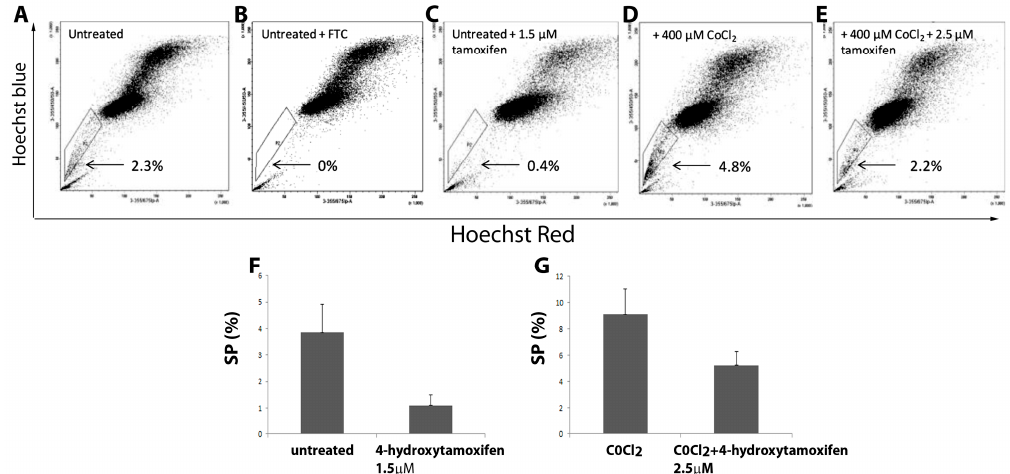
Figure 7. Analysis of the impact of CoCl 2 and drug treatment on MCF7 SP cells. Representative FACS images of SP analysis of MCF7 cells treated with Tamoxifen (Tam) alone or in combination with CoCl 2 . ( A ) Untreated ( B ) Untreated with the addition of FTC to confirm the SP phenotype. ( C ) Treated with 1.5 μ M Tam for 72 h alone. ( D ) Treated with 400 μ M CoCl 2 for 48 h alone. ( E ) Treated